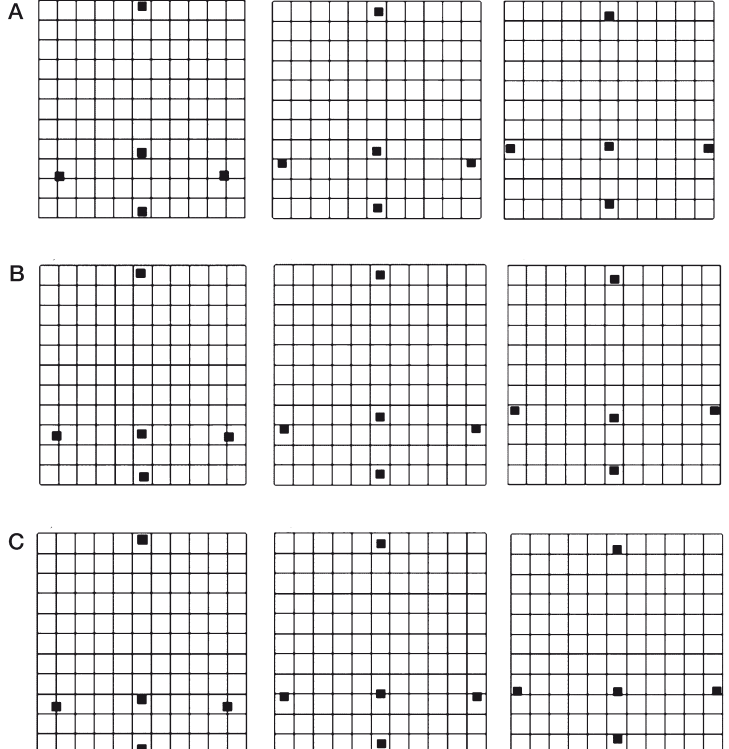
Fig . 4. – Shape variation along the first discriminant function of Figure 3 for Lutjanus argentiventris (A), Lutjanus guttatus (B) and Lutjanus peru (C) visualized using a transformation grid. From left to right each grid shows the predicted shape for discriminate function: left at –4.0, centre at 0.0 and right at